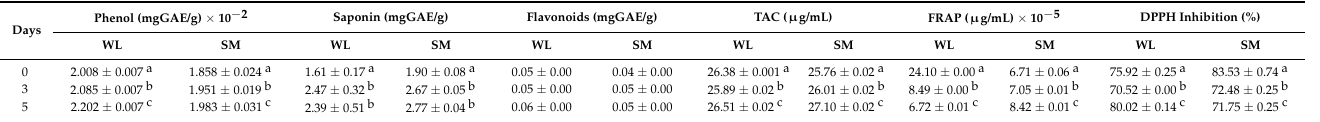
Table 3. Phytochemical components and antioxidant qualities in the fermented leaves of S. monos- tachyus and T. fruticosum